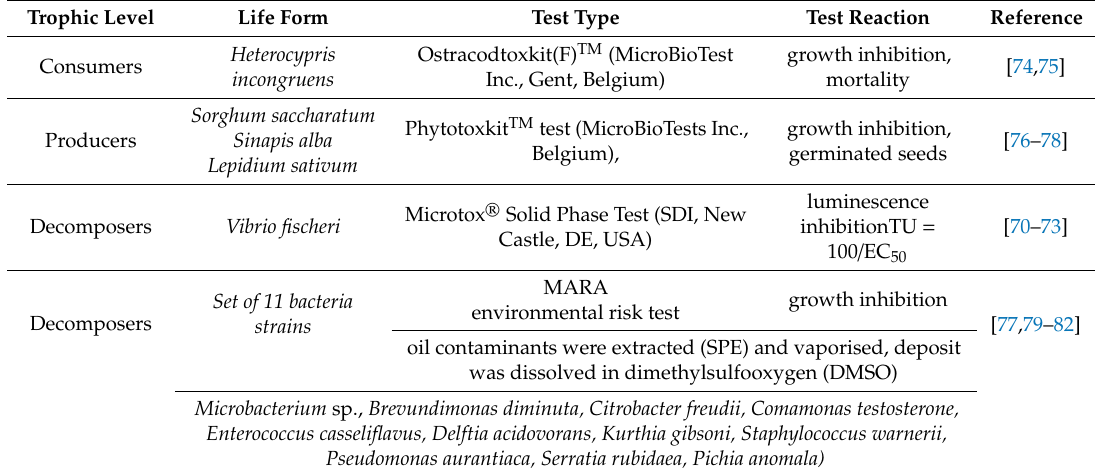
Table 2. Tests used in monitoring of toxicity alternations in soil under